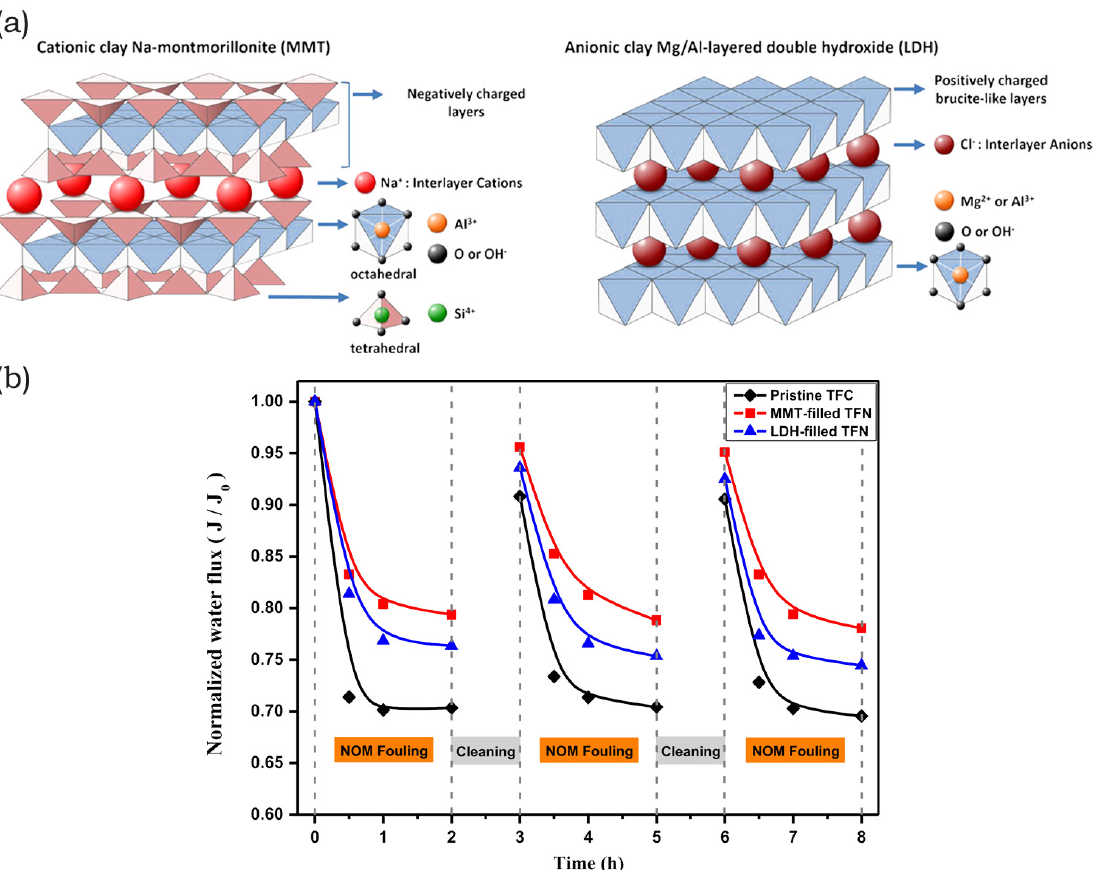
Figure 9. ( a ) Different structures of the cationic clay montmorillonite (MMT), and anionic clay LDH. ( b )Normalized water flux during membrane testing showing different results based on pristine and modified membranes. Reprinted from [200], Copyright (2015), with permission from